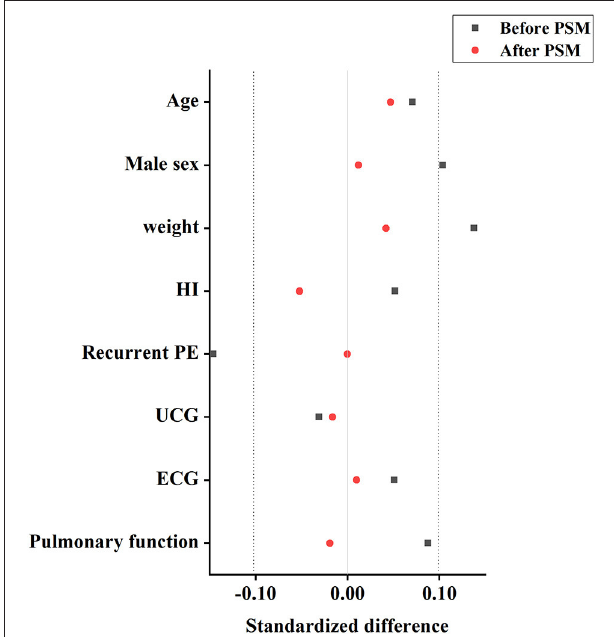
FIGURE 4 | Improvement in covariate balance by propensity scoring. Plot showing improvement in standardized differences in means for all measured covariates in patients in the propensity-matched cohorts. An absolute standardized difference < 0.10 shows adequate matching. HI, Haller index; PE, pectus excavatum; UCG, ultrasonic cardiogram; ECG, electrocardiogram; PSM: Propensity score